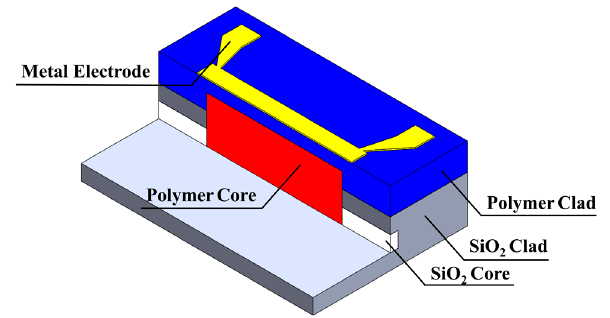
Figure 1. Schematic of the proposed VOA.